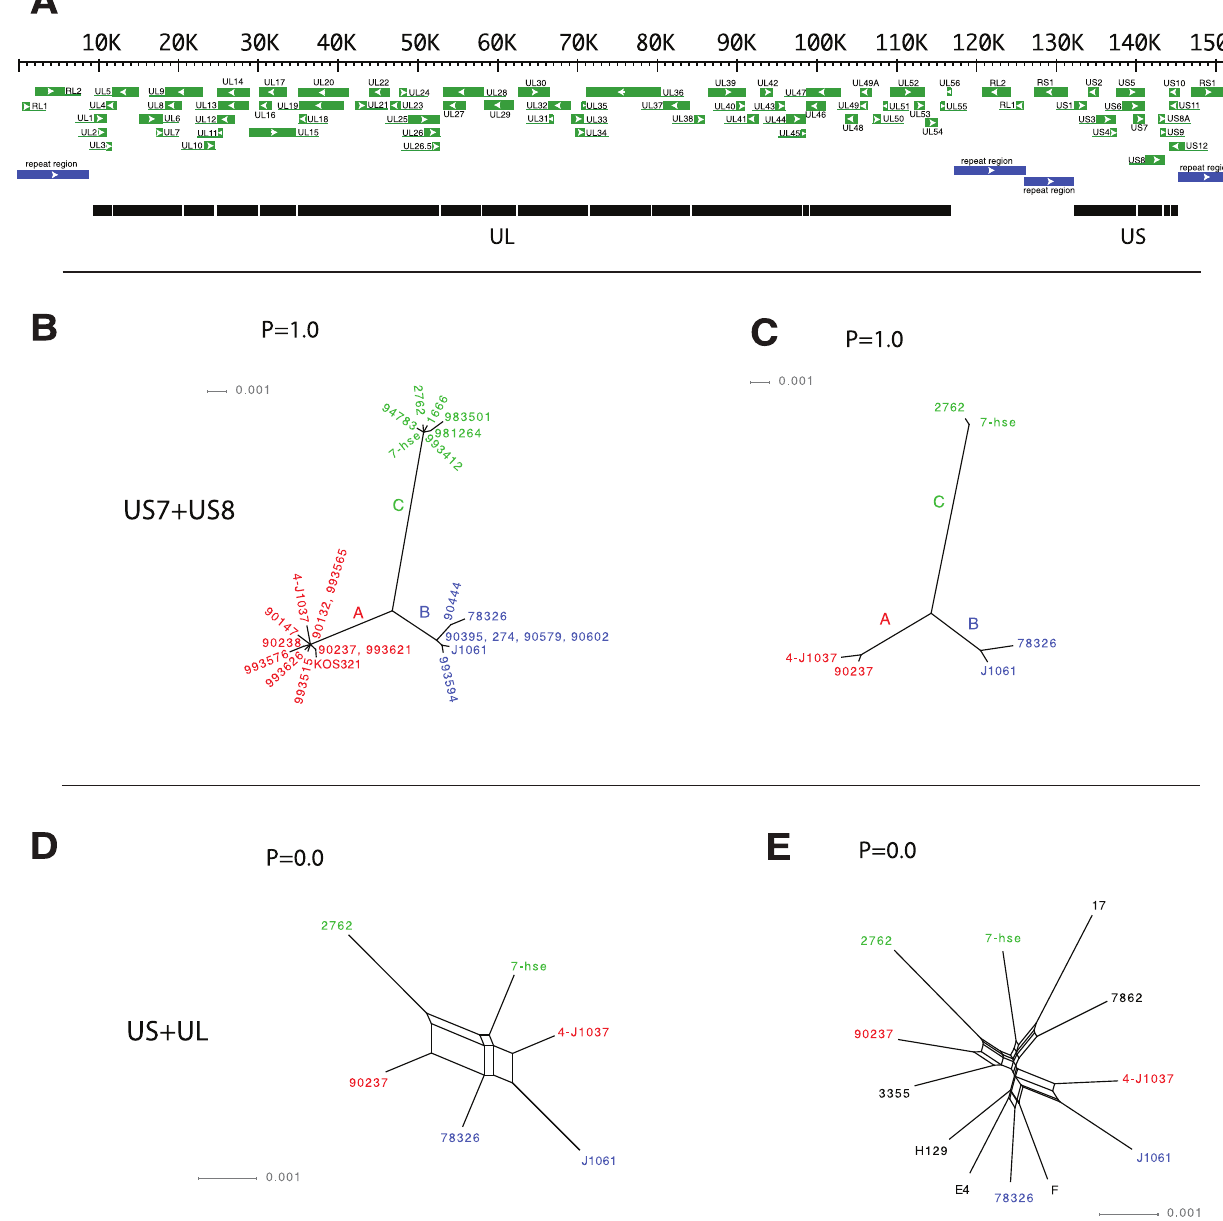
Figure 1. HSV-1 phylogeny. (A) Schematic illustration of the HSV-1 genome. The thick black bar in the bottom depicts the regions that were included in theanalysisafterallrepeatregionsandgaps were removed.Nucleotide positions refertothe laboratorystrain17.(B, C,DandE)Phylogeneticnetworks (splits networks). Networks B and C are based only on US7 and US8, which were the genes analyzed previously by Norberg et al [8]. All strains with recombination crossovers in this region were excluded in order to illustrate the division of the non-recombinant strains into the three distinct evolutionary clades A, B and C. Network B also includes the strains used by Norberg et al, and network C includes only the strains sequenced for this study. Network D is based on the complete genome, including only the strains used in network C (i.e. without recombination crossovers in US7 or US8). Here, recombination crossovers in other parts of the genome prohibit distinct classification of the strains into three distinct clades. Finally, network E is based on the complete genome, including all strains. The network reveals massive recombination and it is irrelevant to attempt to classify a complete genome into any of the three phylogenetic clades A, B or C. The statistical significance for recombination is shown for each dataset.